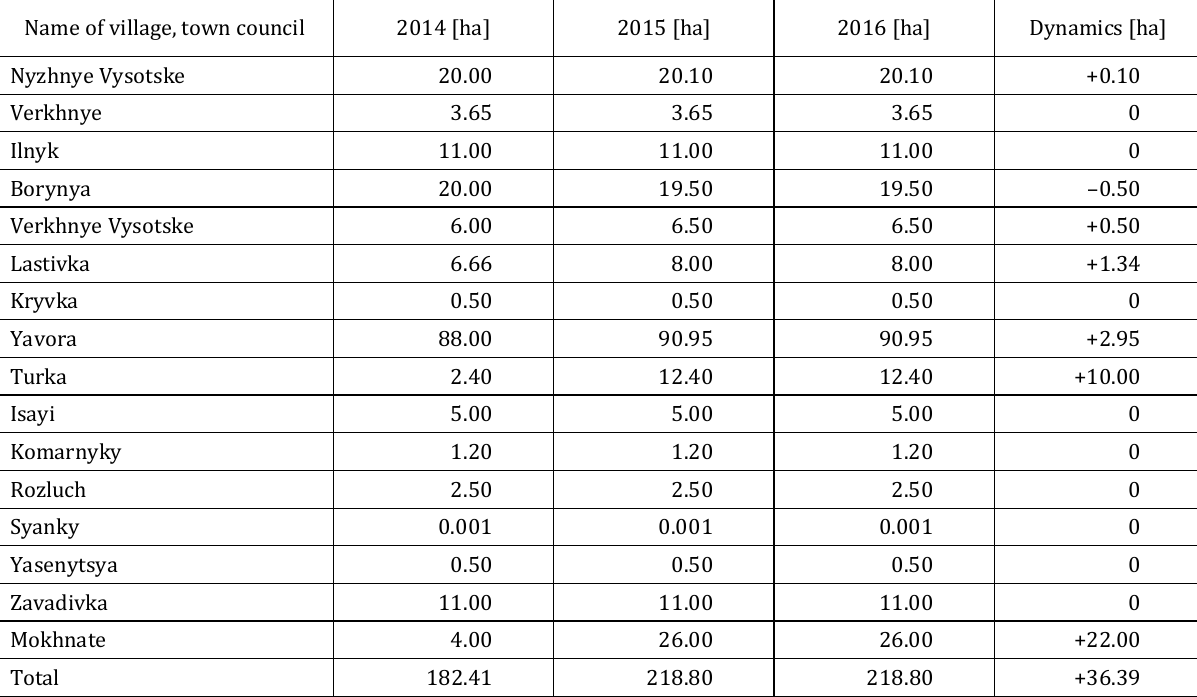
Table 1. Dynamics of the areas occupied by Heracleum sosnovskyi in Turka district of the Lviv region (Conducting measures for the protection…, 2016) Name of village, town